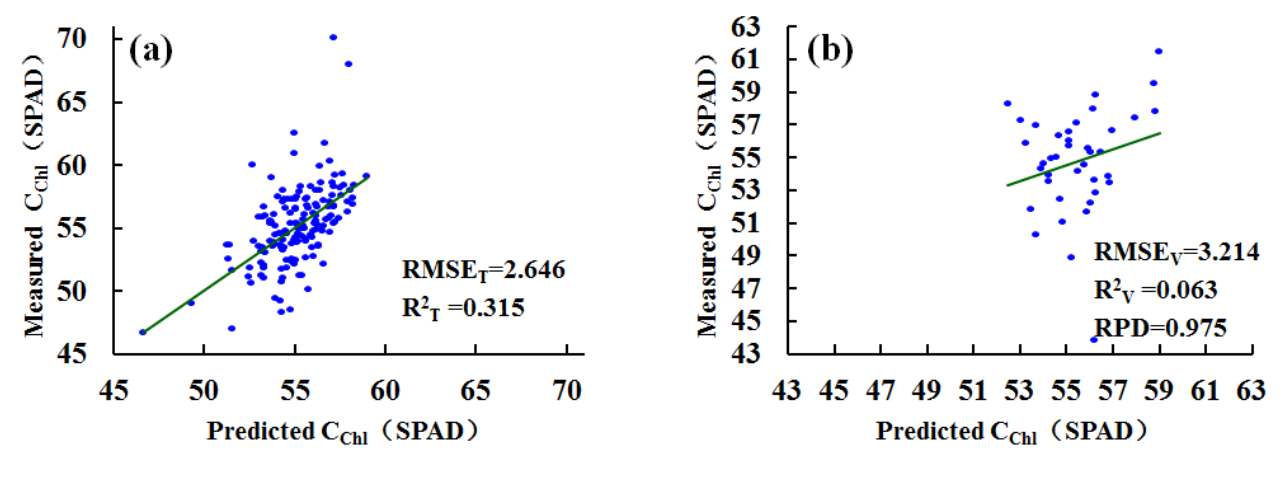
Figure 6. The estimated results of SPAD value for ( a ) training set and ( b ) validation set at filling stage.